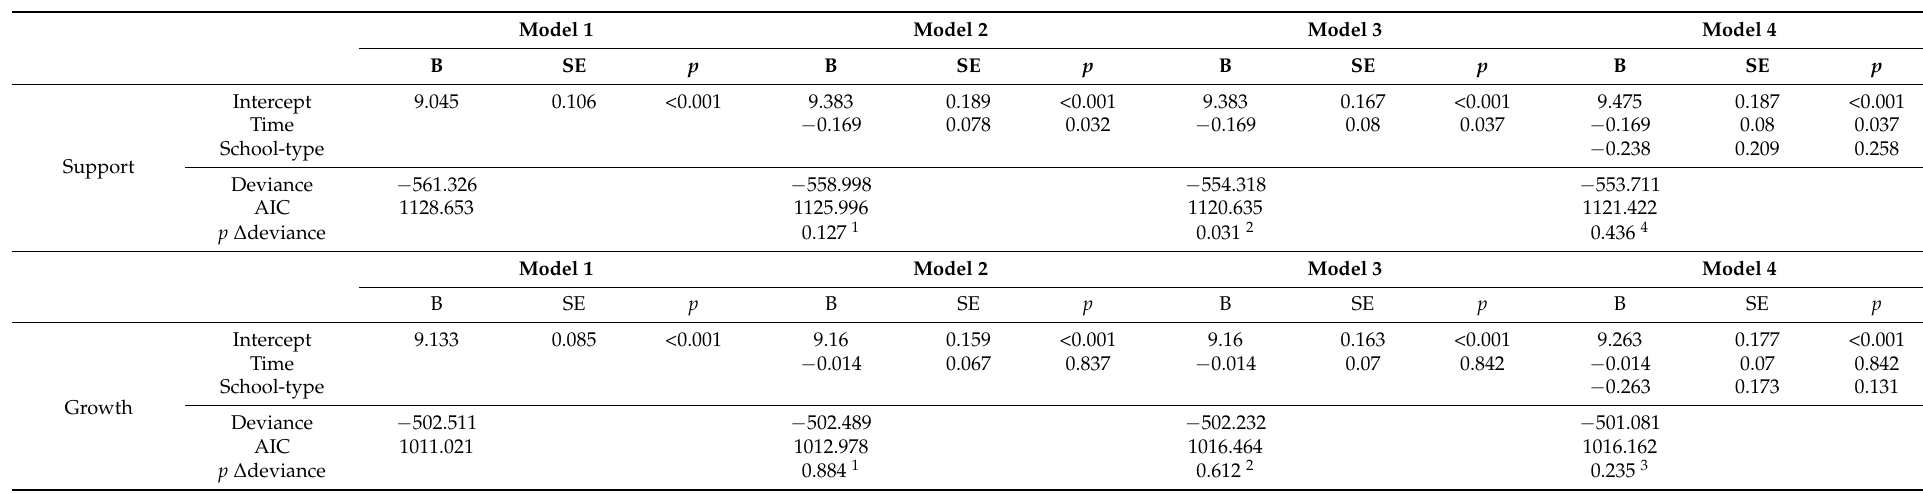
Table 4. Unstandardized coefficients and model fit indices for the four multilevel models for each classroom climate construct. Model 1 = intercept only, Model 2 = random intercept for time, Model 3 = random intercept and slope for time, Model 4 = random intercept for time. Level 1 = time, level 2 is